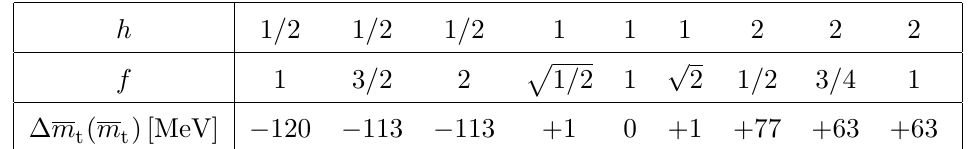
Table 6. Parameter variation and associated shifts in the extracted value of m to the observable with the default values ( h; f ) = (1 ;